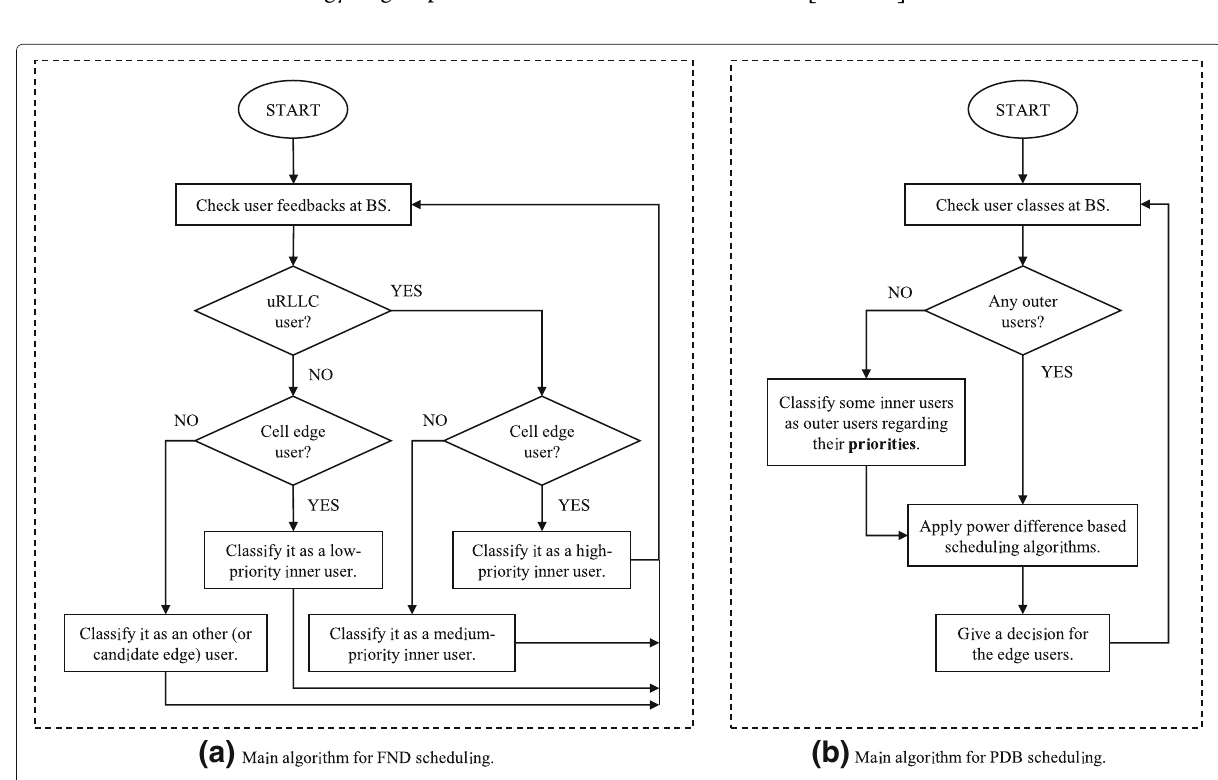
Fig. 5 Flowcharts of the proposed main algorithms for a FND scheduling and b PDB